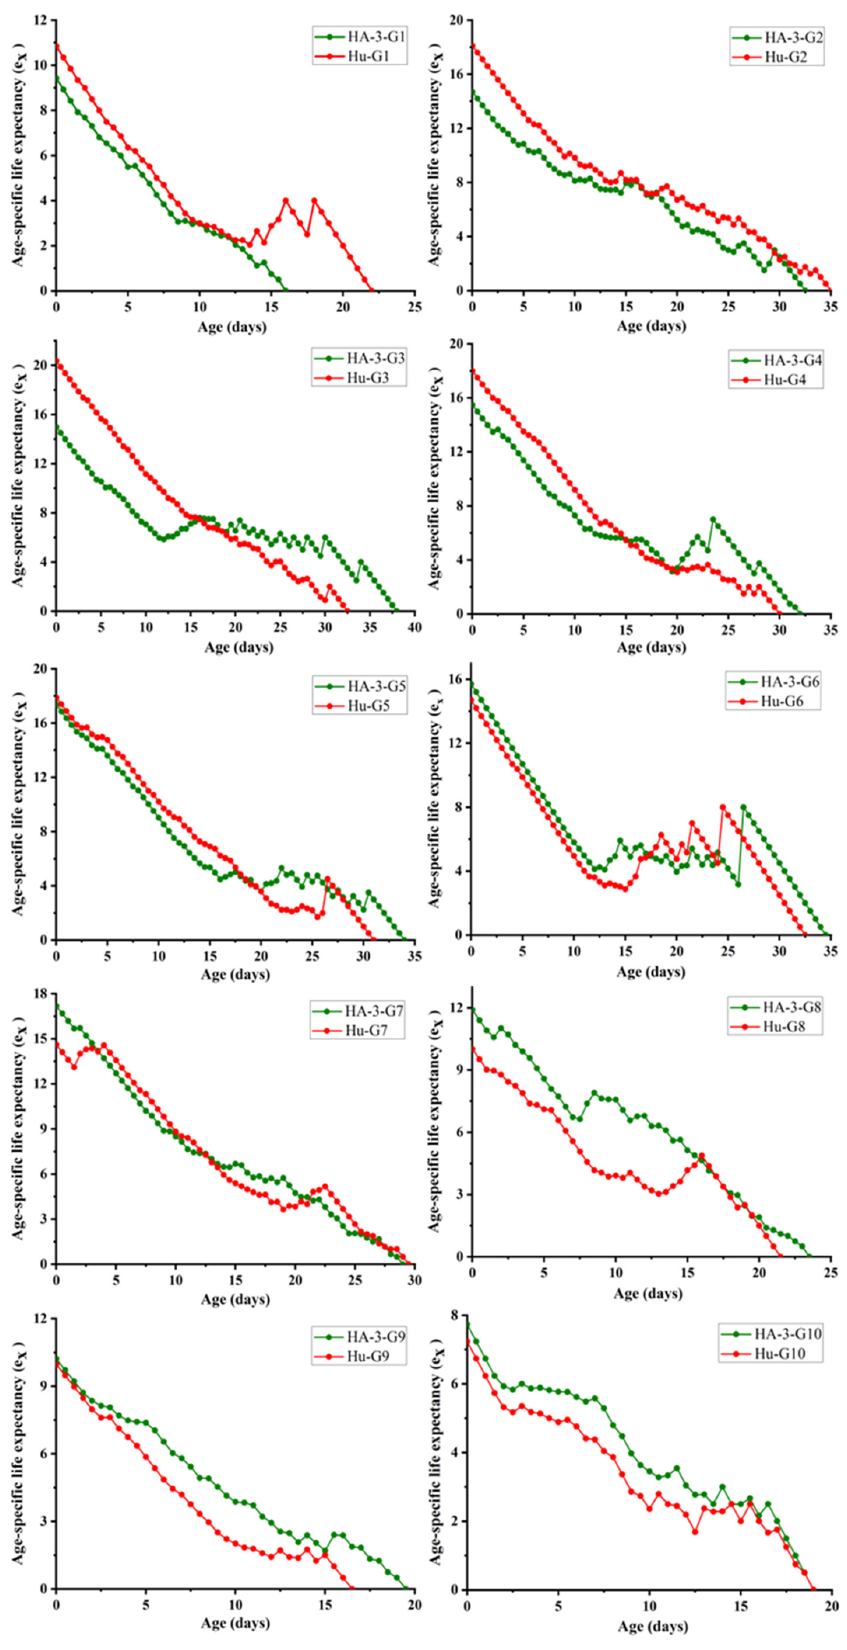
Figure 5. Age-specific life expectancy of SAA G1-G10 on HA-3 and Hu cultivars.